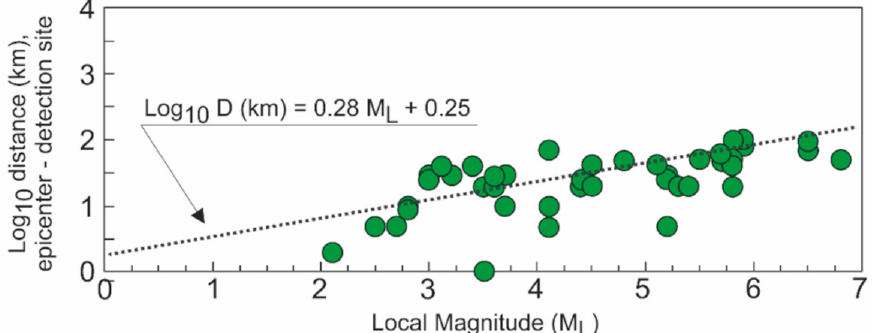
Figure 8. Distance vs, magnitude diagram for Italian geofluids anomalies considered in this